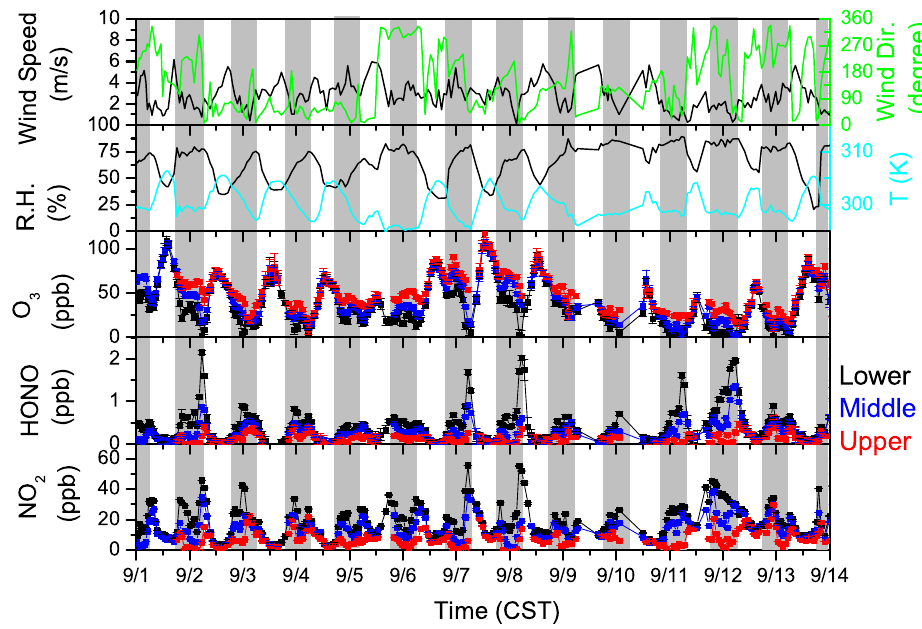
Fig. 3. Overview of LP-DOAS observations of NO 2 , HONO and O 3 mixing ratios (lower: 20–70m, middle: 70–130m and upper: 130– 300m) from 1–14 September 2006 during TRAMP in Houston, TX. Measurements of temperature, relative humidity and wind speed and direction at 70m are also shown. Nighttime data are shaded in grey to differentiate from daytime observations.